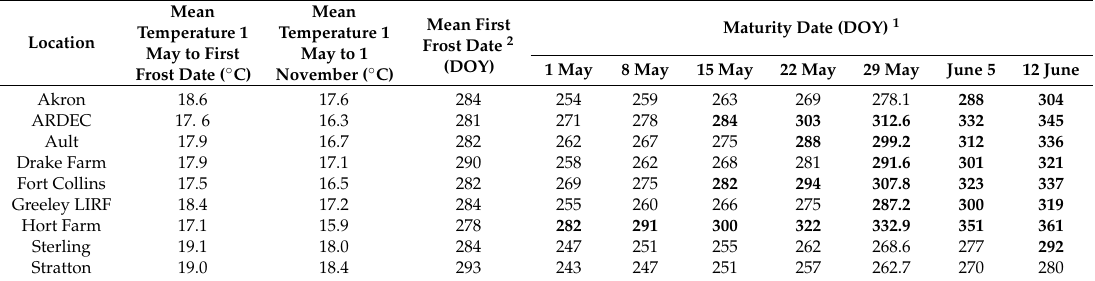
Table 2. Mean maturity dates for seven planting dates at nine locations in northeastern Colorado.